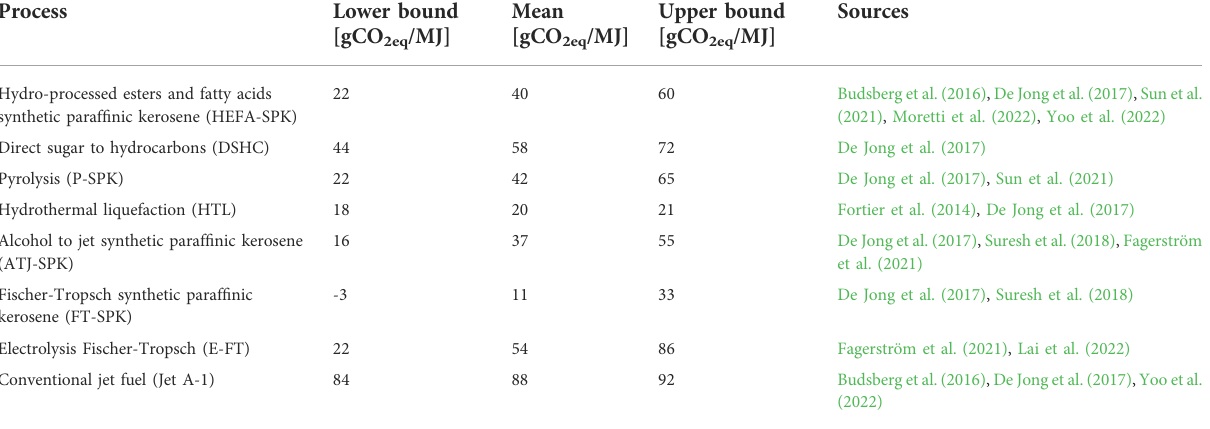
TABLE 3 GHG emissions for the SAF benchmarks selected for the study showing cradle-to-gate